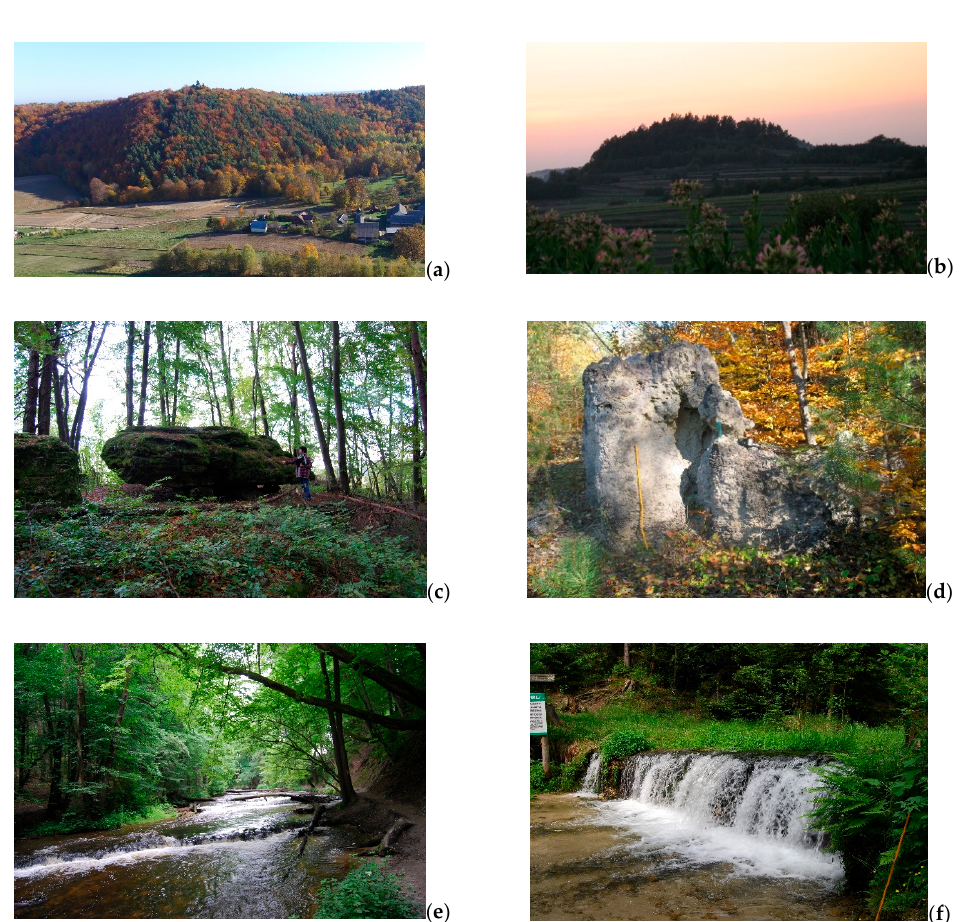
Figure 5. Examples of landforms: ( a ) Czubatka Hill, ( b ) Kamienna Hill, ( c ) Diabelskie Kamienie rocks in Werchrata, ( d ) “Kopiec termitów” rock in the non-existent Zaj ą ce village, ( e ) waterfalls in the Tanew River, ( f ) waterfall in the Jele ń river.